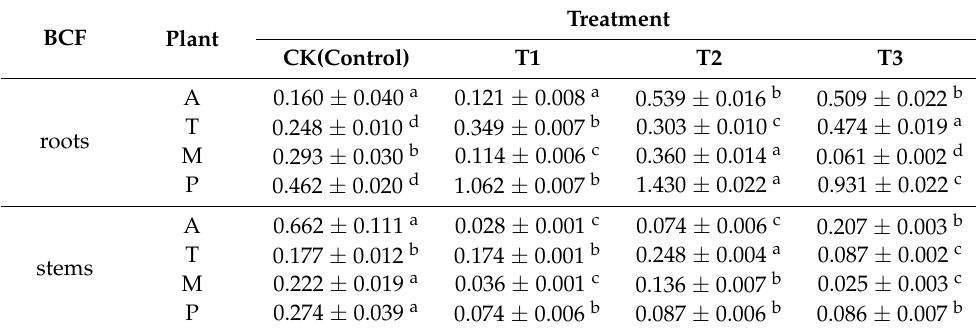
Table 4. Effect of Pb pollution level on lead bioaccumulation factor in soil-plant